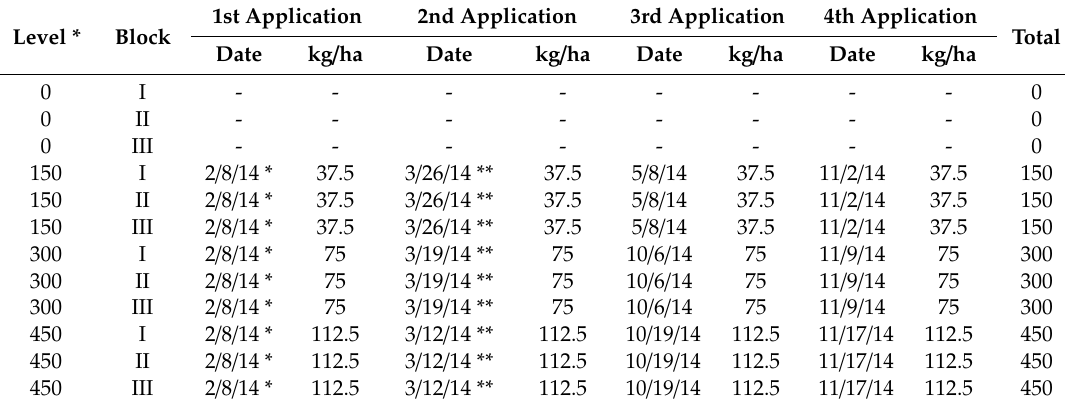
Table 1. Nitrogen fertilization (kg / ha of N) applied to each paddock and its respective date of application during the experimental